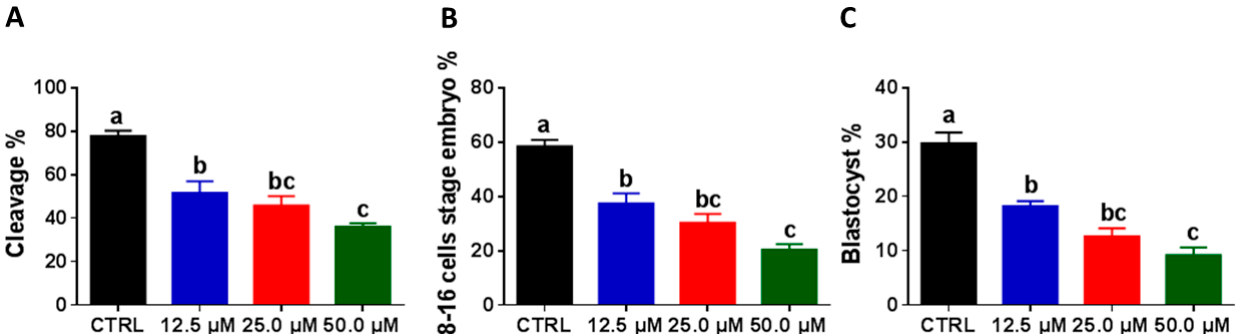
Figure 3. The developmental competence of embryos after juglone treatment. ( A ) Day 4 total cleavage. The development rates of 8–16 cell-stage ( B ) and day 8 embryos ( C ). The different letters on the columns reflect statistical significance ( p < 0.05).